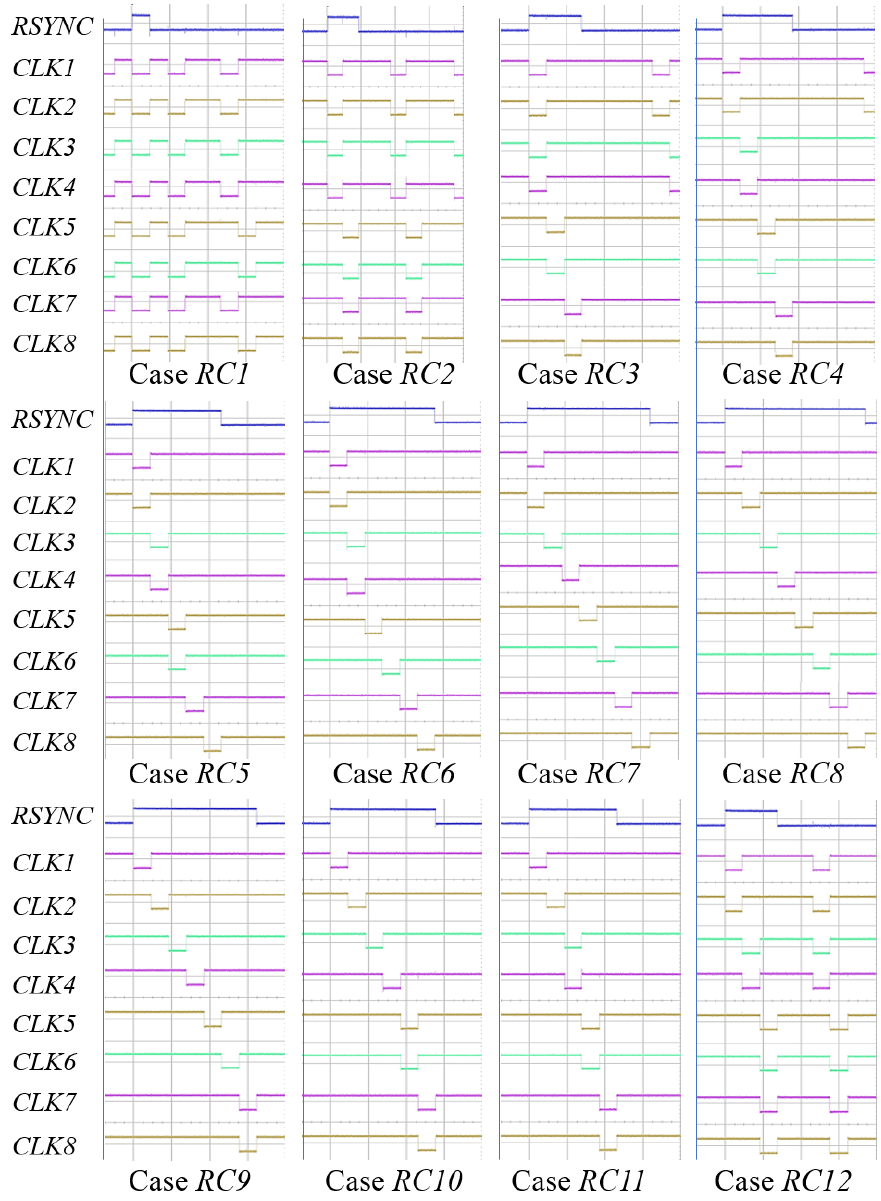
Figure 11. Measured waveforms of clock waveforms for 12 region cases. SYNC pulses indicate the corresponding regions for 12 cases,